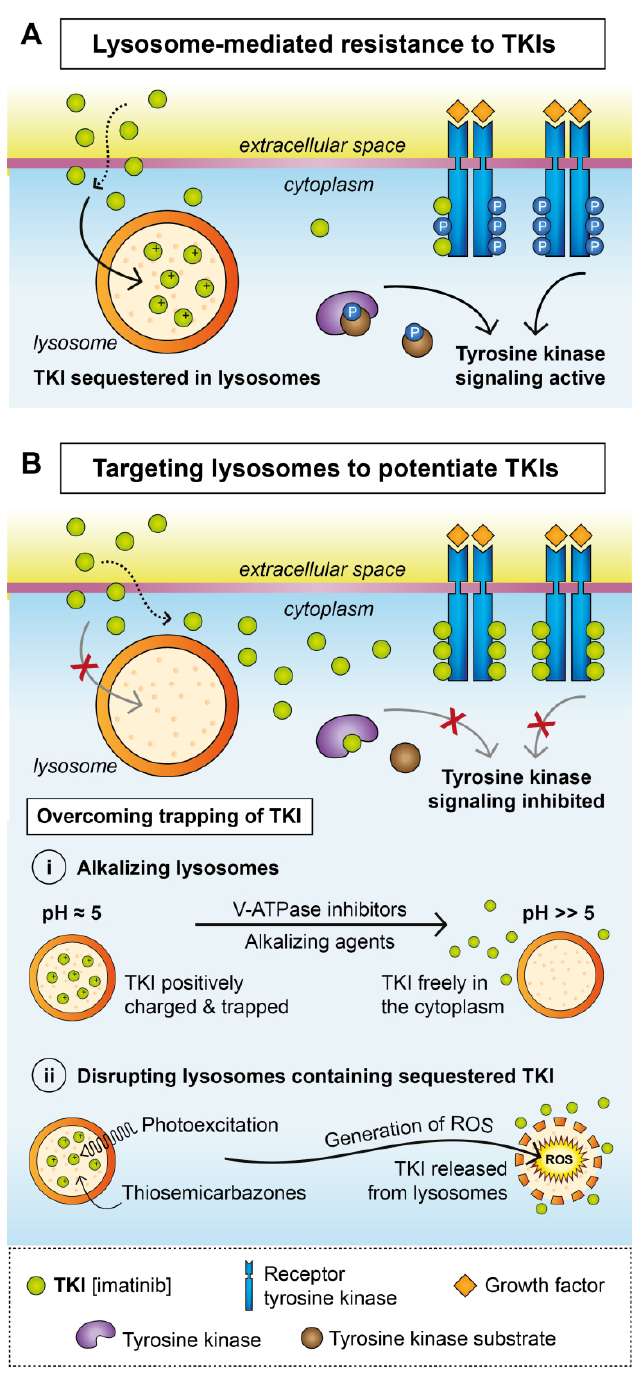
Figure 2. Lysosomes in resistance to TKIs. ( A ) Sequestration of TKIs into lysosomes provides a mechanism of resistance to TKIs. ( B ) Targeting lysosomes by alkalizing their milieu ( i ) or disrupting their integrity ( ii ) can potentiate the effects of TKI treatment.